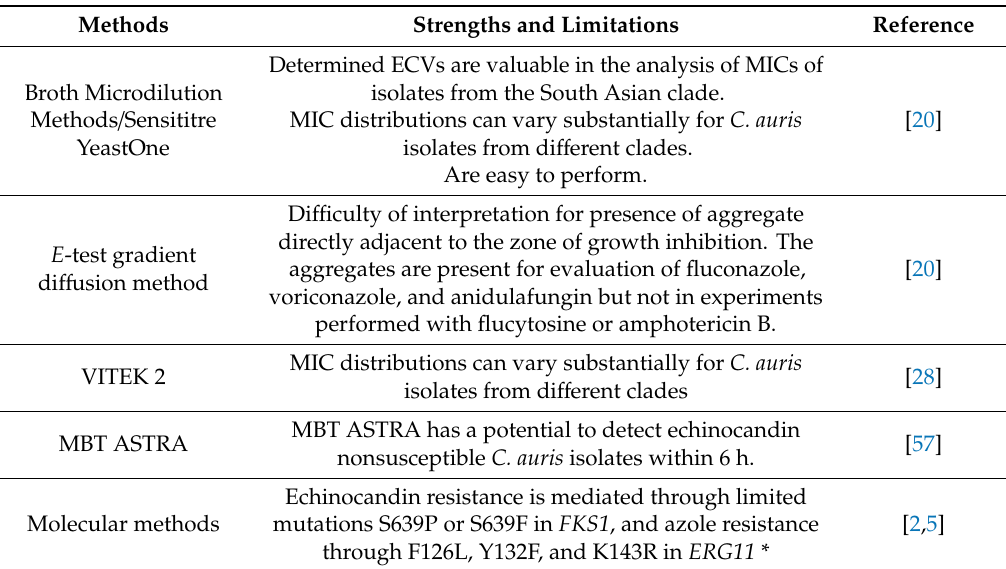
Table 3. Strengths and limitations of AFST used for C.